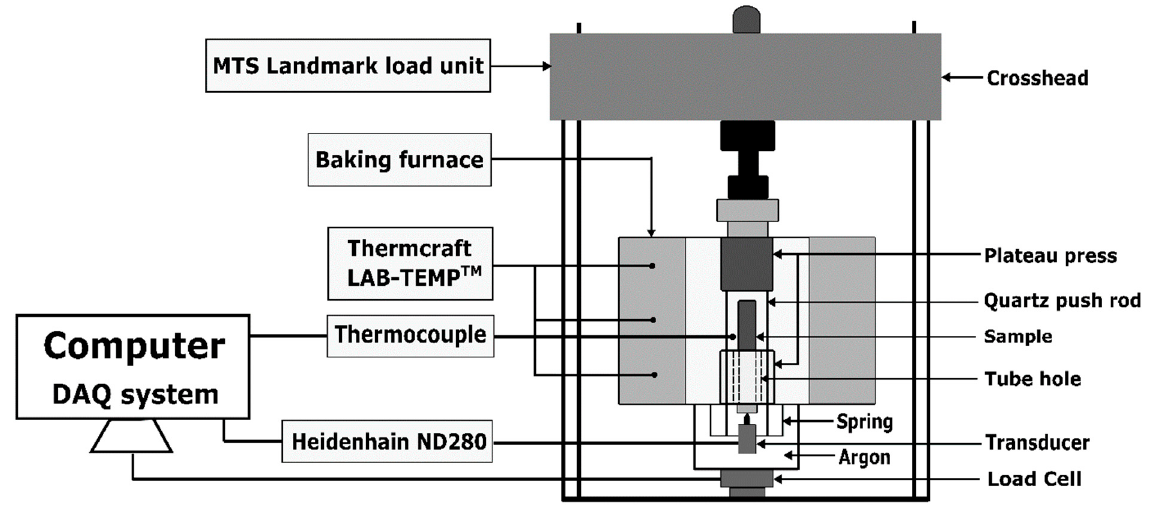
Figure 6. Schematic representation of a pneumatic system for the creep test.